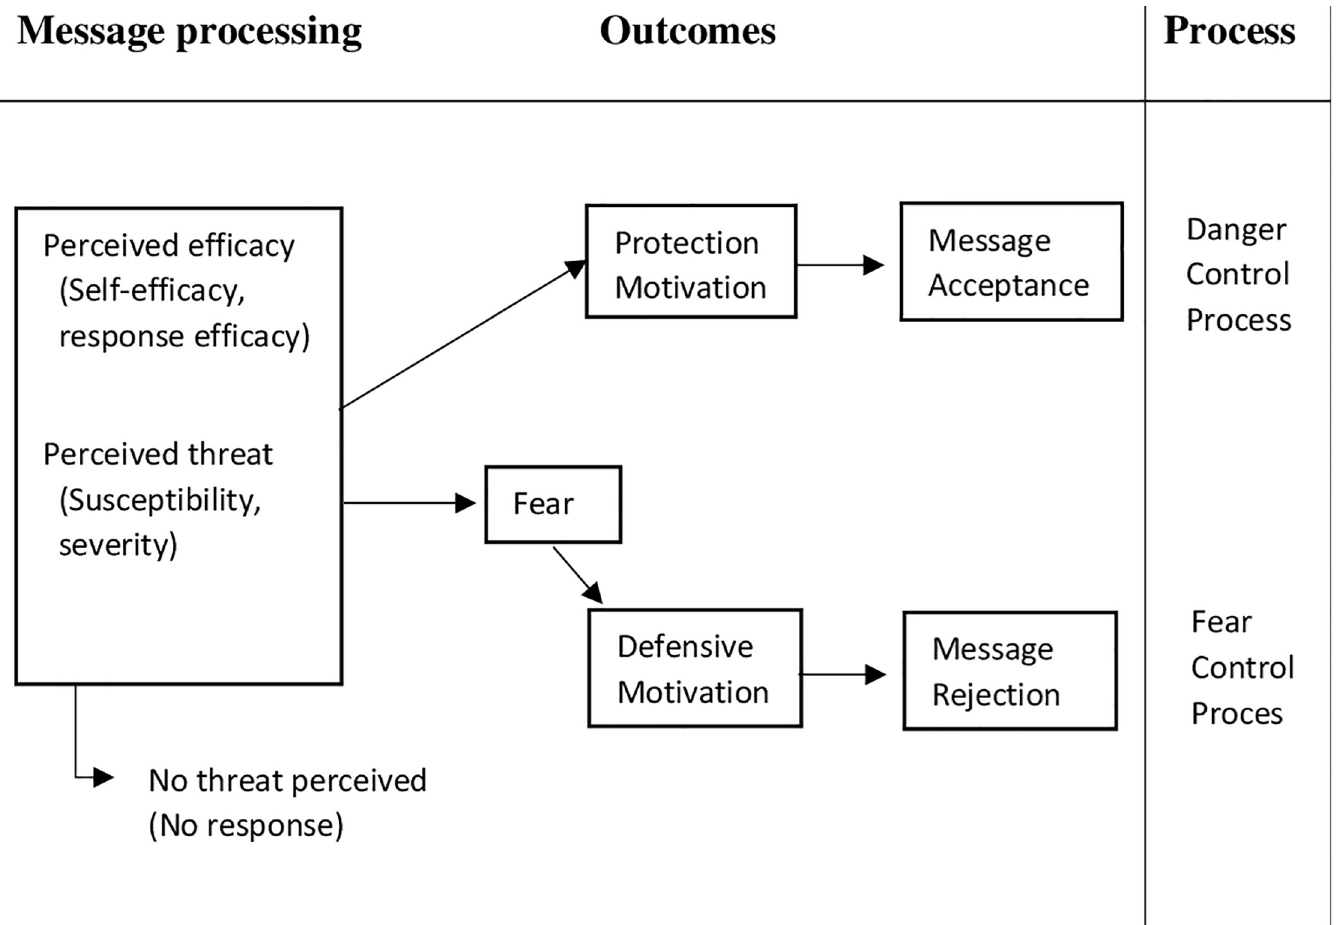
Fig 1. The Extended Parallel Process Model (EPPM) [8].